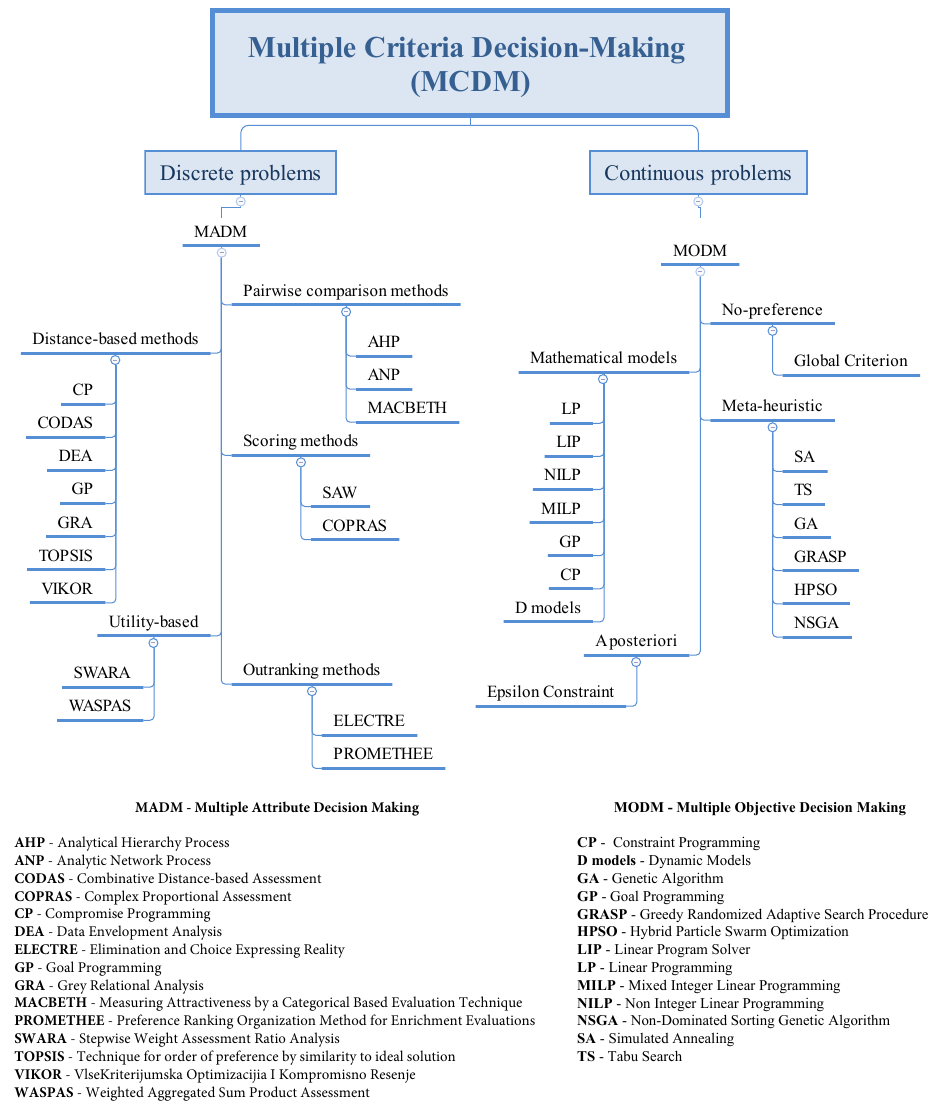
Figure 2. The classification of MCDM